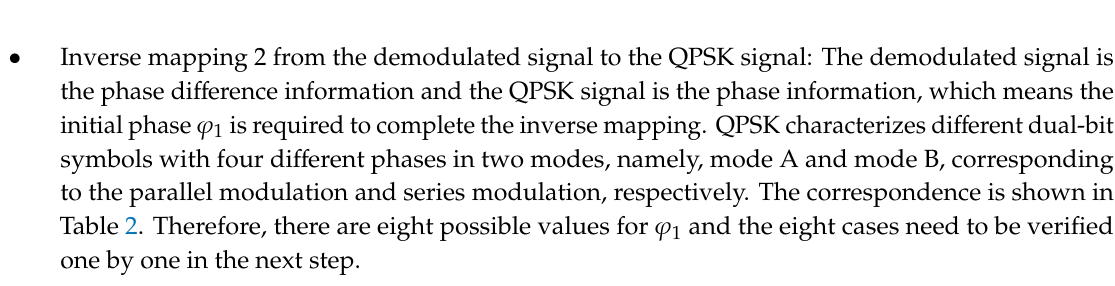
Table 2. Coded relationship between the input dual-bit symbols and the modulated